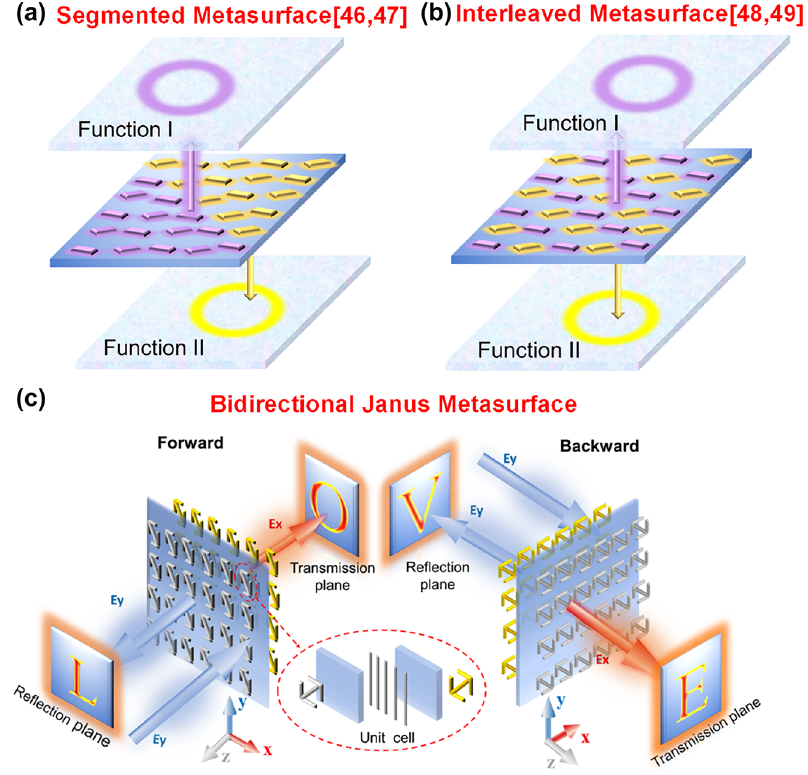
Figure 1: Schematic diagram of the multi- functional metasurface. (a) Illustration of the segmented metasurface. (b) Illustration of the interleaved metasurface. (c) Schematic illustration of the proposed non-interleaved multifunctional